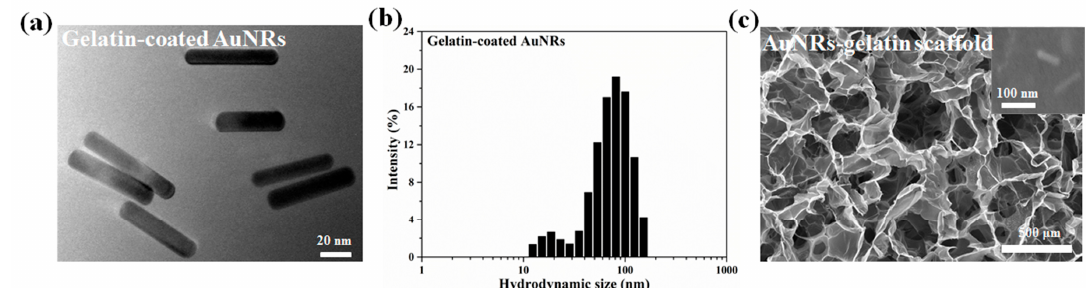
Figure 1. Transmission electron microscope (TEM) image of gelatin-coated gold nanorods (AuNRs) ( a ); hydrodynamic size distribution of gelatin-coated gold nanorods (AuNRs) ( b ); scanning electron microscope (SEM) image of AuNRs–gelatin composite porous scaffold ( c ), insert in c is the magnified image of the pore surface showing the embedding of AuNRs in gelatin matrices.